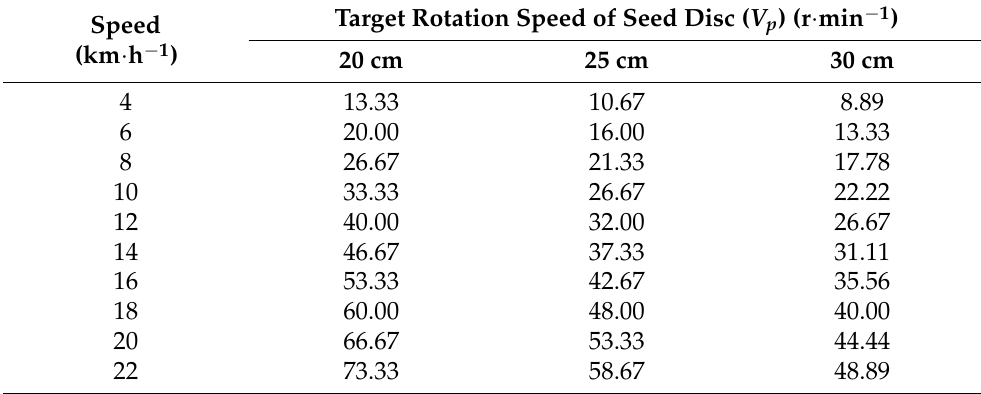
Table 2. The calculation result of the target rotation speed of the seed disc of the seed metering